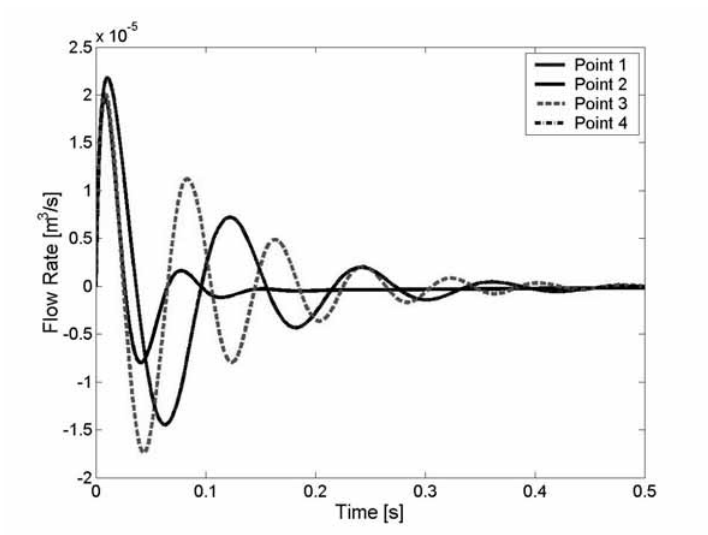
Fig. 34. Optimized inertia track flow rate transient